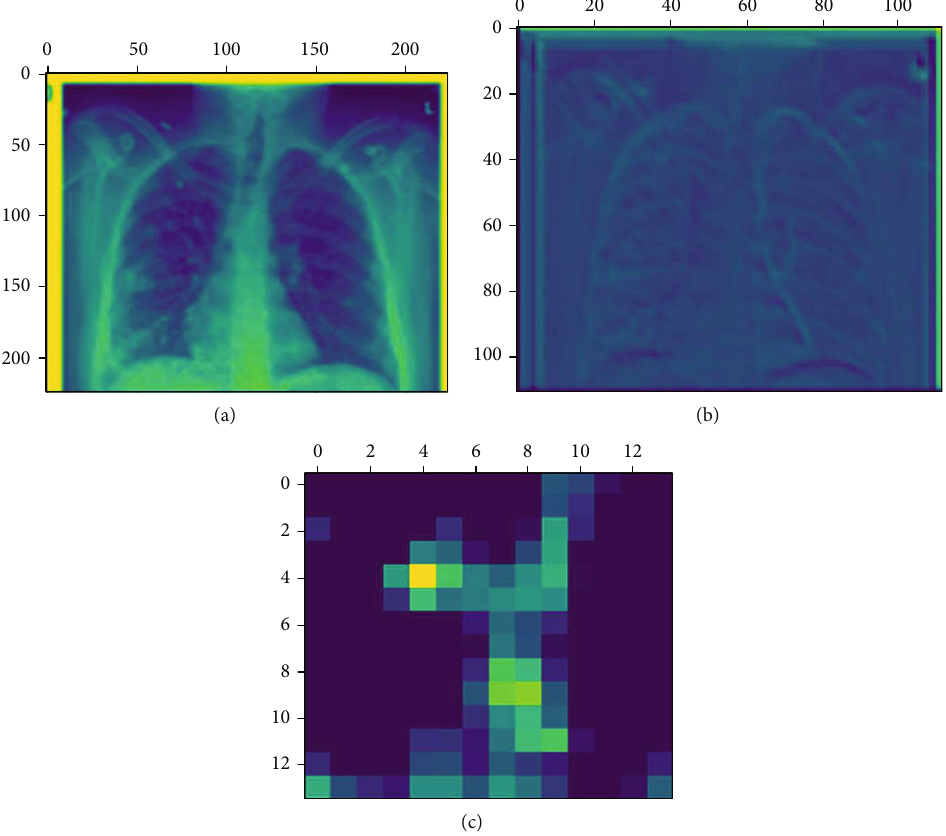
Figure 3: The dimension reduction technique as visualized in VGG16 networks: (a) the 24 th channel of the activation for the 1 st layer of the COVID-19 X-ray image, (b) the 1 st channel of the activation for the 5 th layer of the COVID-19 X-ray image, and (c) the 1 st channel of the activation for the 17 th layer of the COVID-19 X-ray